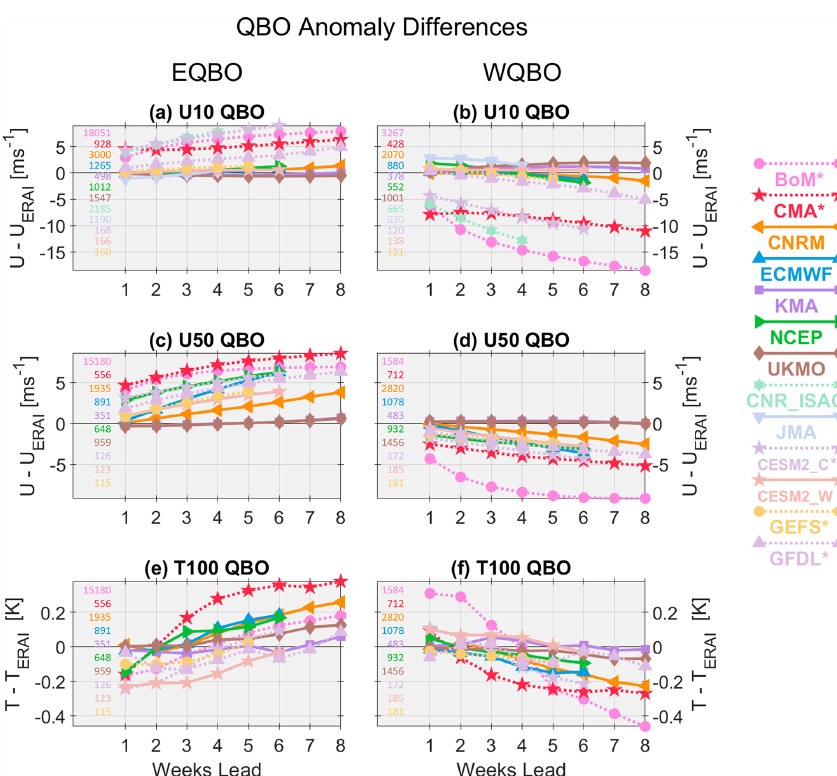
Figure 3. Time series of tropical stratospheric anomaly differences (from reanalysis) composited for easterly and westerly phases of the QBO in the subseasonal hindcasts. (a, b) QBO defined using 10hPa, 5 ◦ S–5 ◦ N zonal wind; (c, d) QBO defined using 50hPa, 5 ◦ S–5 ◦ N zonal wind; and (e, f) 100hPa, 5 ◦ S–5 ◦ N temperature in the QBO phases defined using 50hPa winds. All composites are based on November– February initializations only, with the number of initializations in each composite shown in each